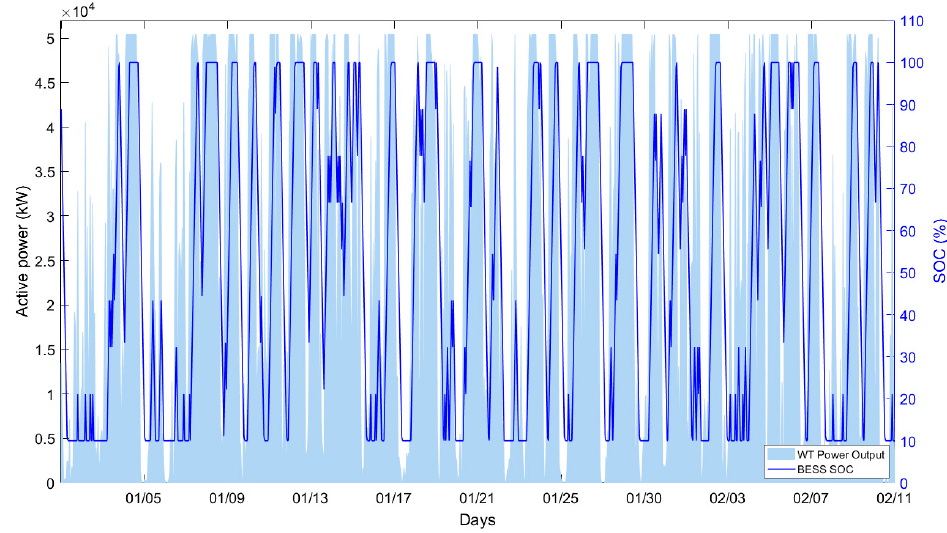
Figure 9. Result of simulation performed in Homer Pro.